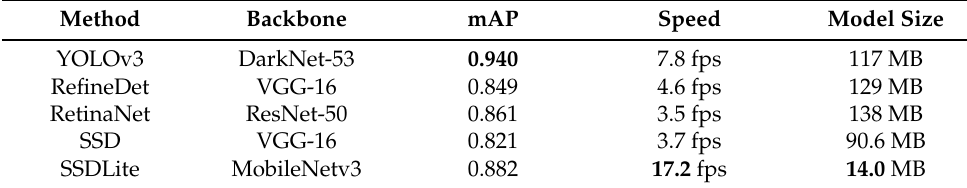
Table 3. Performance of different detection methods on the Diver test set.